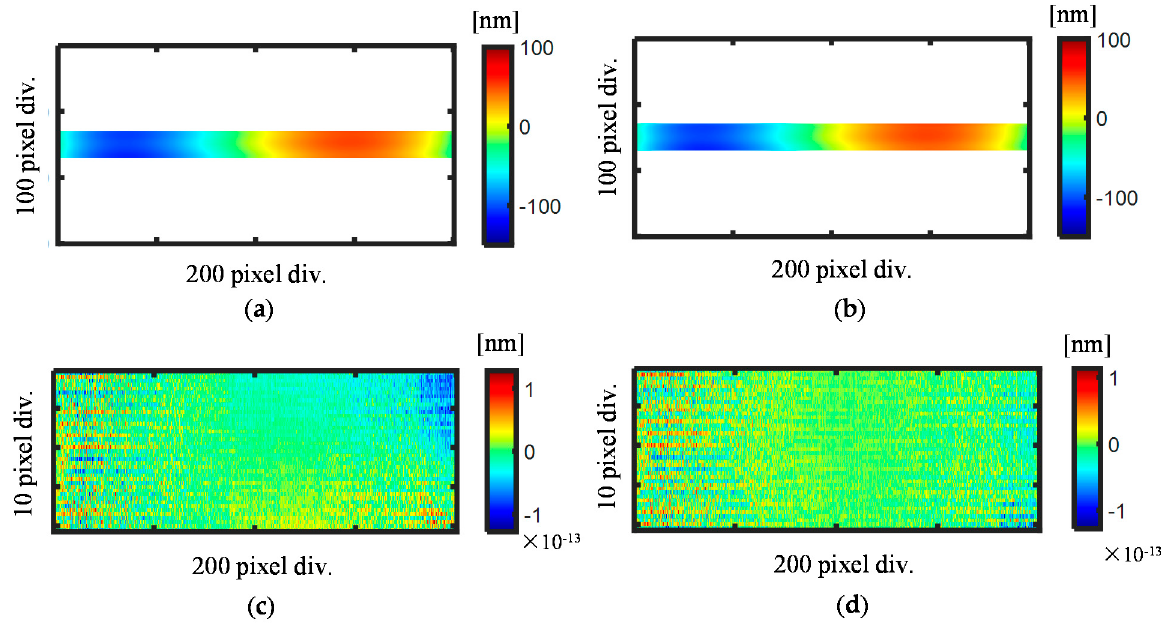
Figure 8. Reconstructed pitch deviation results using the stitched first-order diffracted beams and the pitch deviation maps. ( a ) Evaluated pitch deviation obtained by using the stitched first-order diffracted beams; ( b ) Evaluated pitch deviation obtained by directly stitching the pitch deviation maps; ( c ) Difference obtained from the two results ( a , b ); ( d ) Difference between the evaluated pitch deviation and the simulated pitch deviation in Figure 5c.